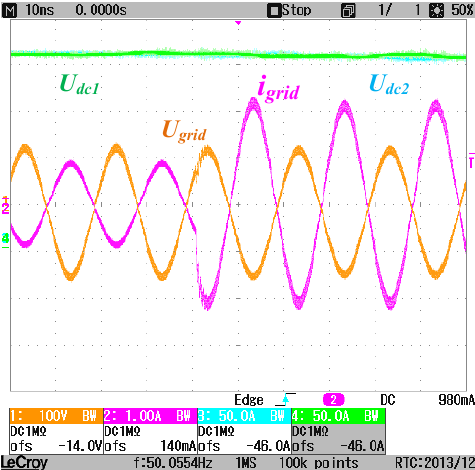
Fig. 10. Step-change of the load for single-phase DC/AC part of converter at stand-alone mode of operation. From top: voltage on upper capacitor ( U dc1 ), voltage on lower capacitor ( U dc2 ), grid voltage ( U grid ) and inverted grid current ( i grid ).